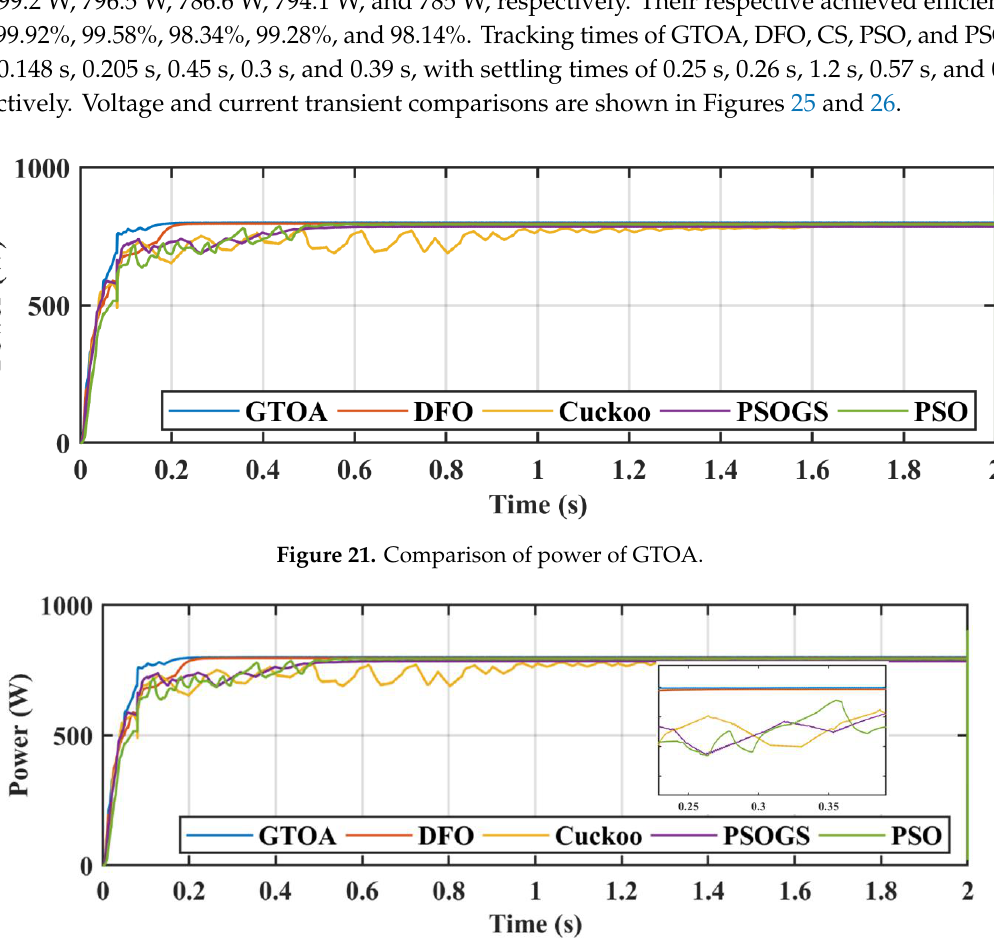
Figure 20. Comparison of current transients of GTOA.